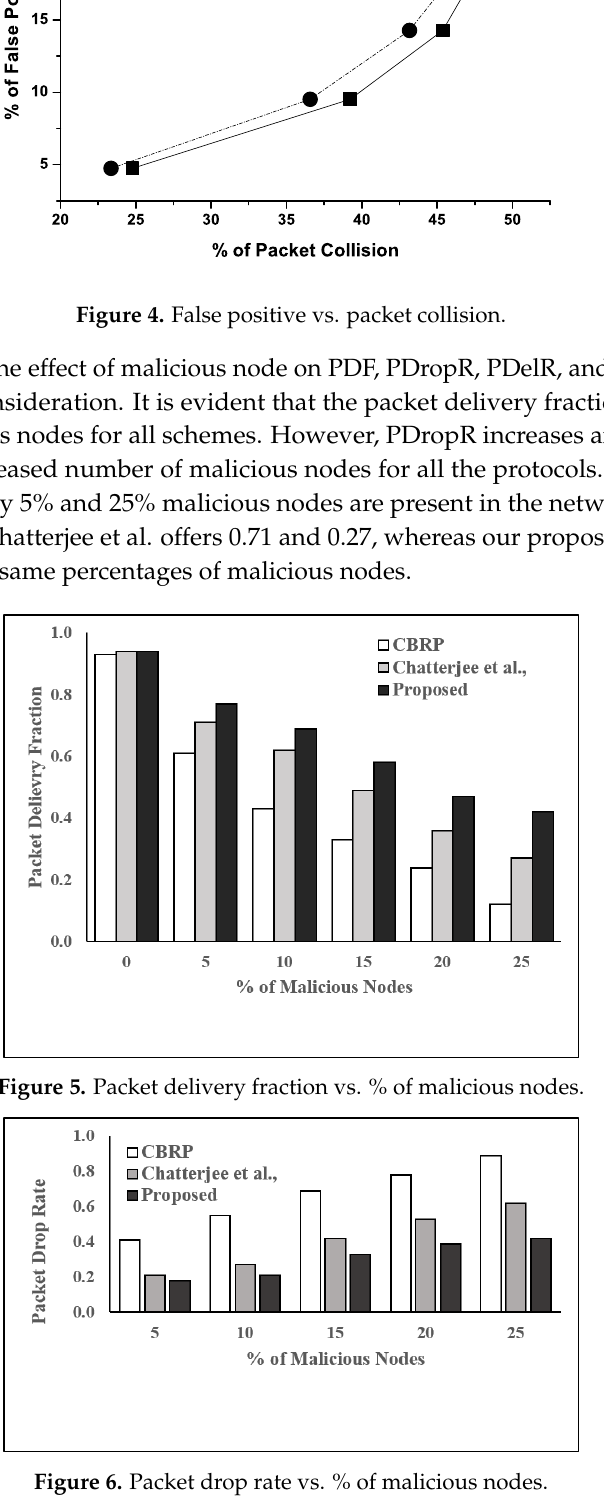
Figure 6. Packet drop rate vs. % of malicious